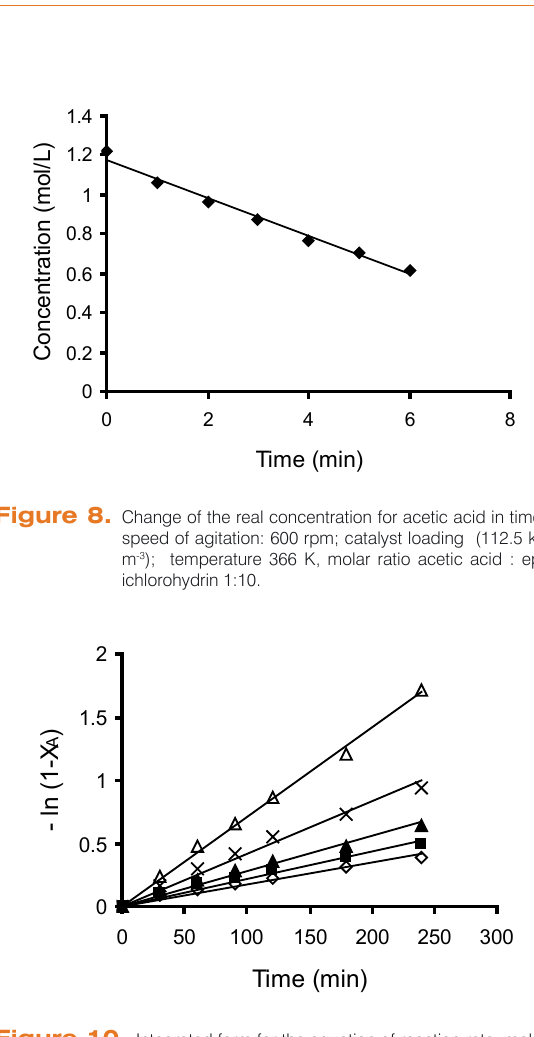
Figure 10. Integrated form for the equation of reaction rate; molar ratio acetic acid: epichlorohydrin 1:1; speed of agita - tion 600 rpm; catalyst loading (112.5 kg m -3 ); tempera - ture: ◊ 343K; ■ 348K; ▲ 353K; × 358K; ∆